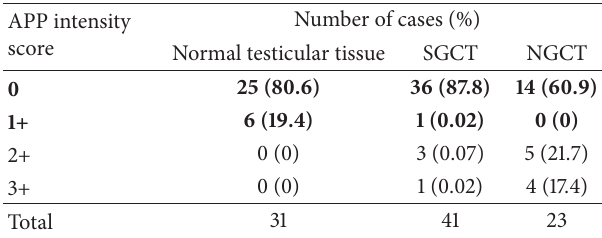
Table 1: Immunoreactivity of APP in human testicular